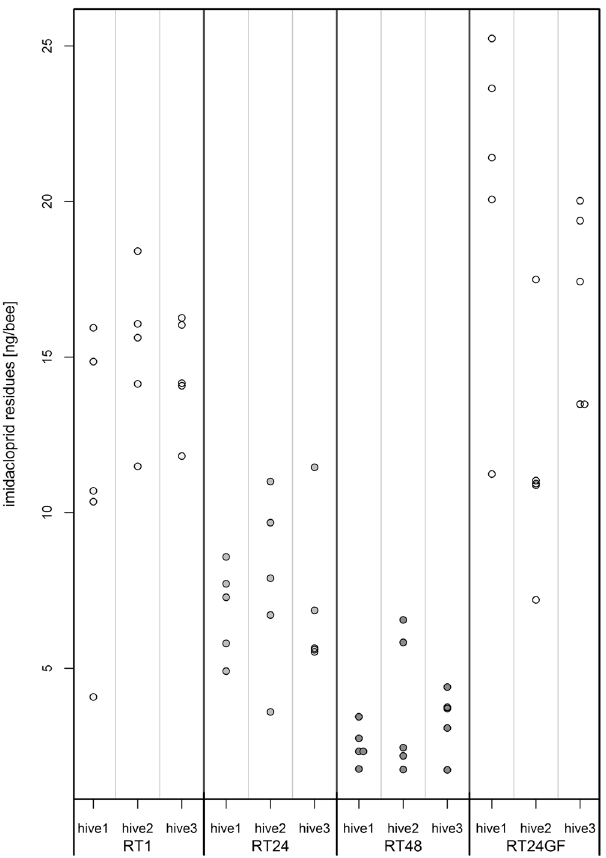
Figure 3. Group feeding resulted in significantly higher whole-body imidacloprid residues compared to the individually fed honeybees. Individual honeybees were fed with a single dosage of 41 ng/bee (RT1, RT24, RT48). Alternatively, groups of ten honeybees per cage were fed with 410 ng/cage imidacloprid (RT24GF). One dot indicates imidacloprid value of one sample of ten bees. Five samples of each hive are presented in one column (n = 150 bees/group). Statistical comparison with an ANOVA yielded a significant effect of the applied treatment (p < 0.001) and multiple comparisons using Dunnett contrasts resulted in RT1 vs. RT24GF: